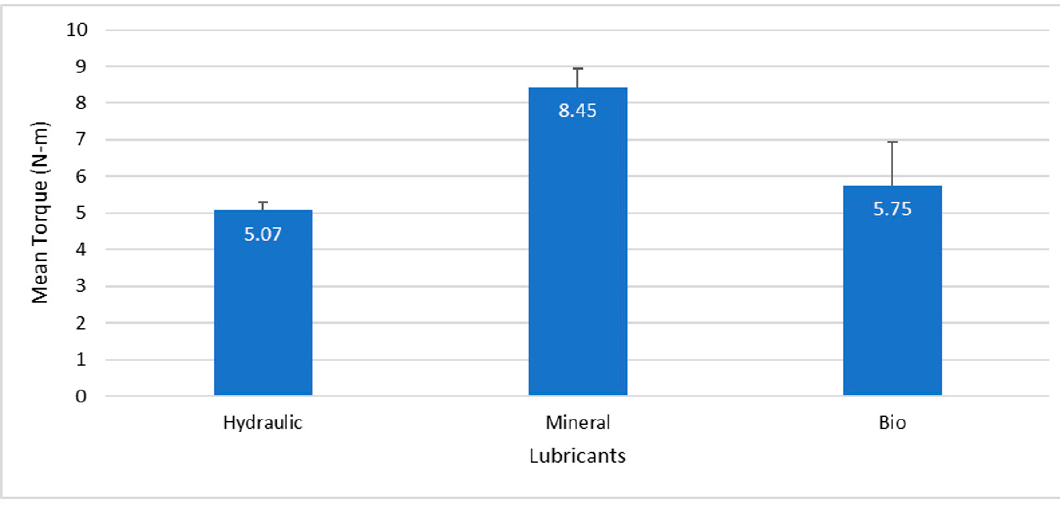
Figure 9. Average tapping torque.